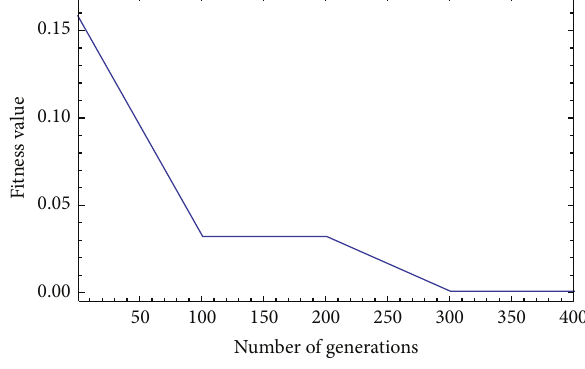
Figure 11: Performance graph for Case